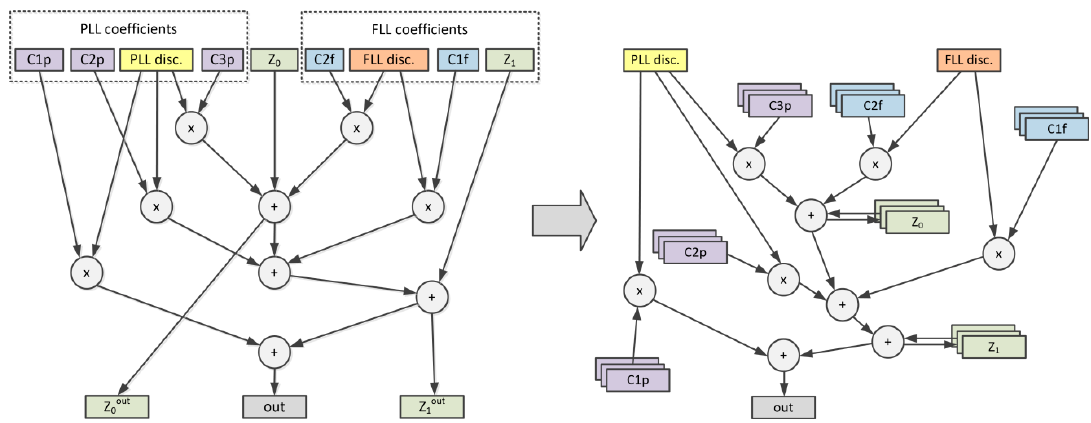
Figure 6. Identification of local variables in phase-locked loop (PLL) loop filter DAG.